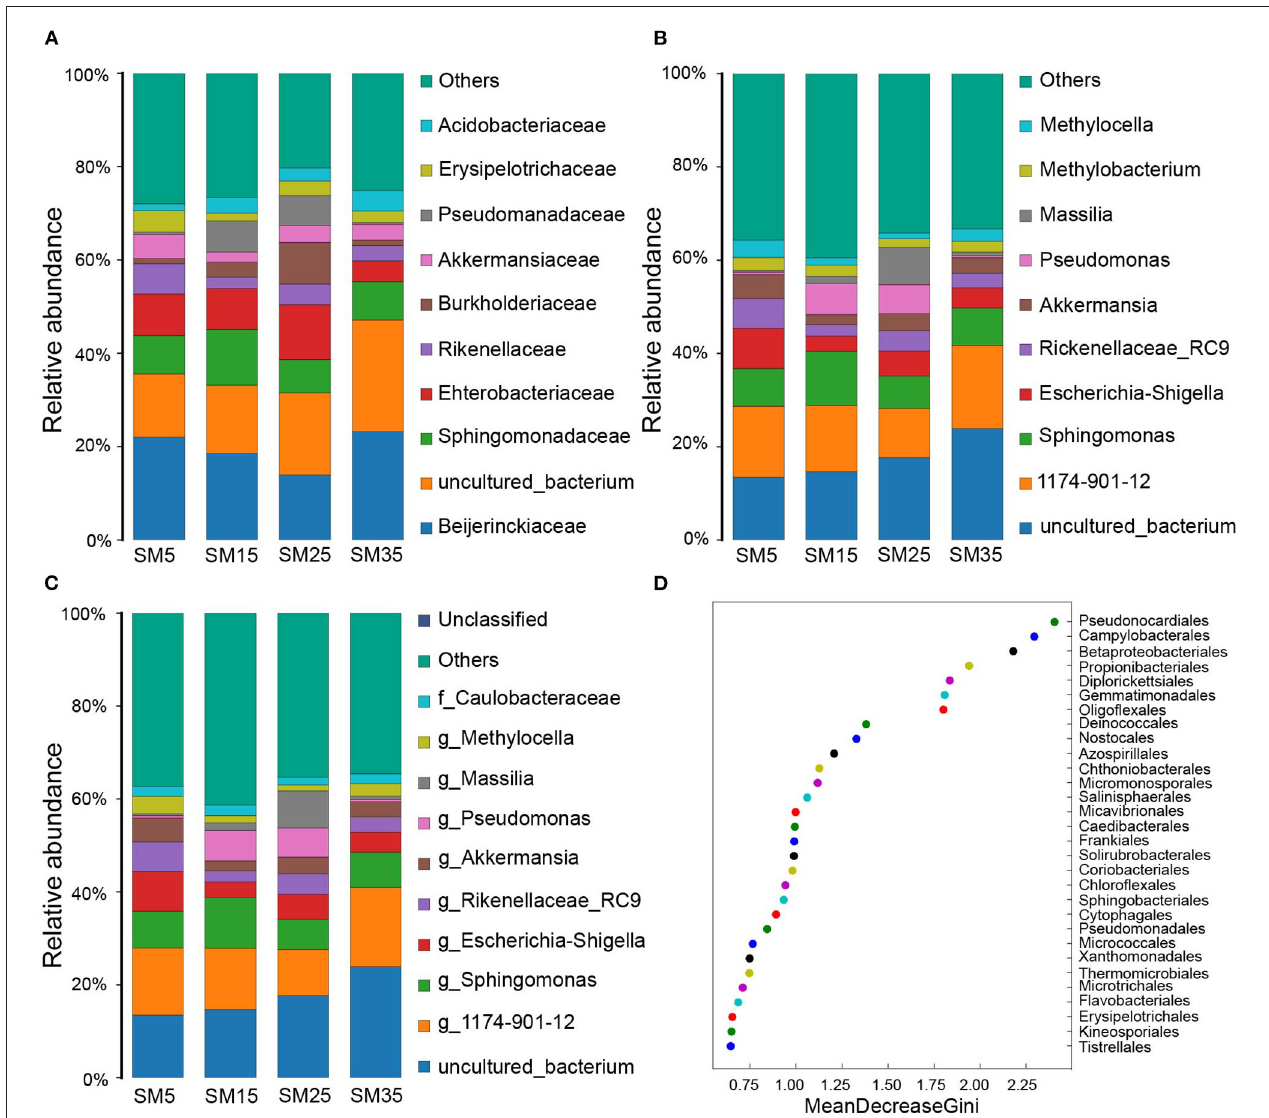
FIGURE 3 | Abundance of phyllosphere bacterial communities with relative abundance > 0.8% as classified to (A) family; (B) genus; and (C) species taxonomic levels. (D) The top 30 bacterial orders identified by the predictive Random Forest model using the mean decreasing Gini score. SM5, SM15, SM25, and SM35 represent stand ages of 5, 15, 25, and 35 years,